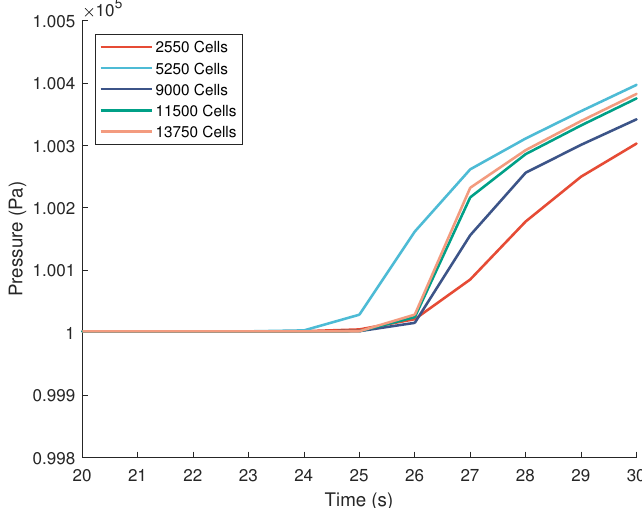
Figure A1. Convergence analysis for different amounts of